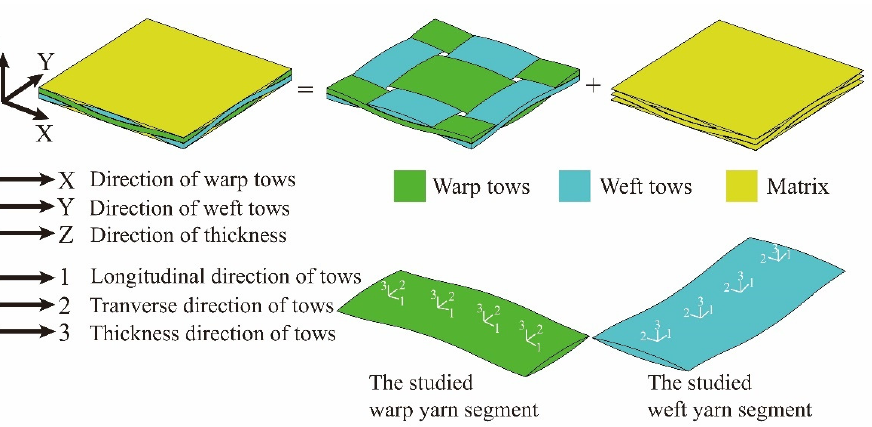
Figure 2. RUC of the plain-woven fabric composites and the studied warp and weft yarn segments. The undulation path of the studied warp yarn segment is presented in Figure 3a. r U represents the radius of the arcs and L RUC represents the length of the mesoscale RUC. H stands for the distance between the horizontal center line of the RUC and the center of the arcs in the undulation path: